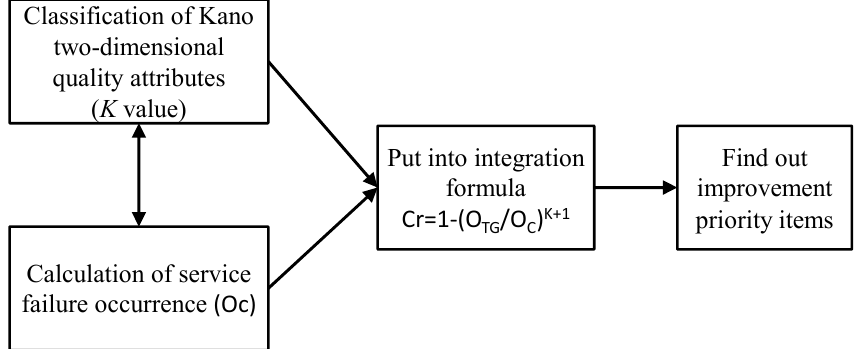
Figure 3. Integration of the failure mode and effect analysis (FMEA) and the Kano model.